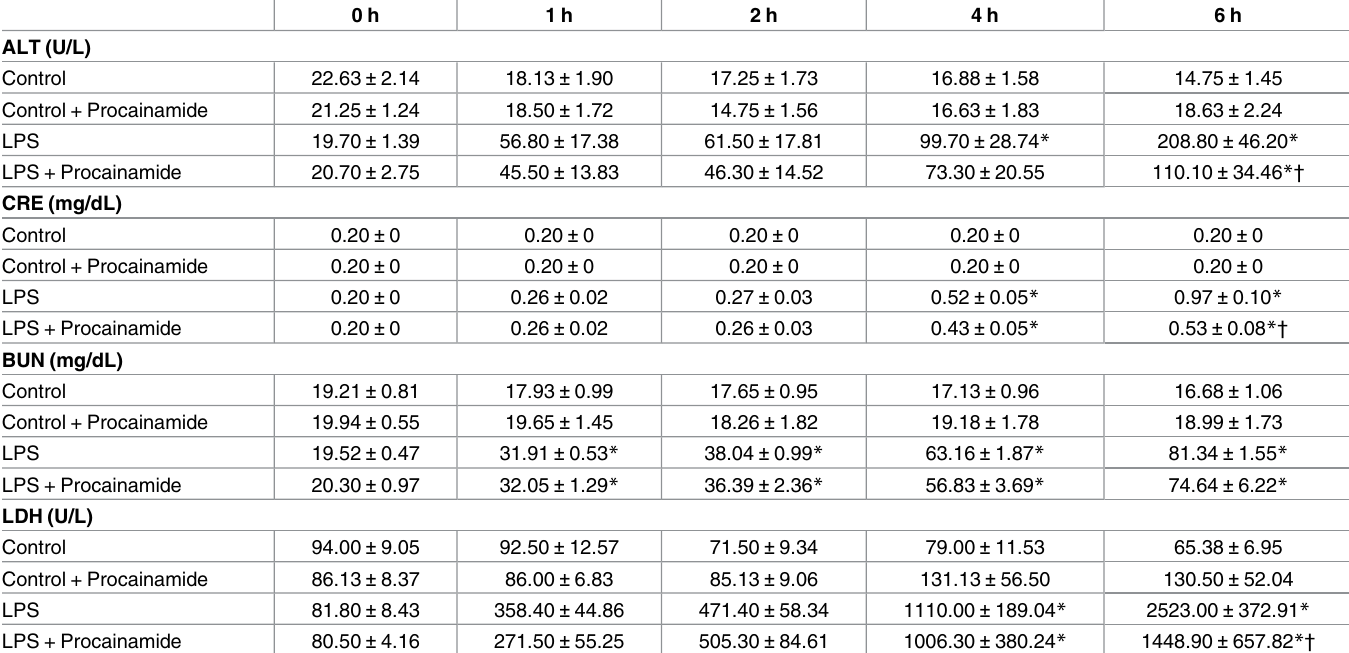
Table 1. Effects of procainamide on organ function/injury in LPS-induced endotoxemic rats.